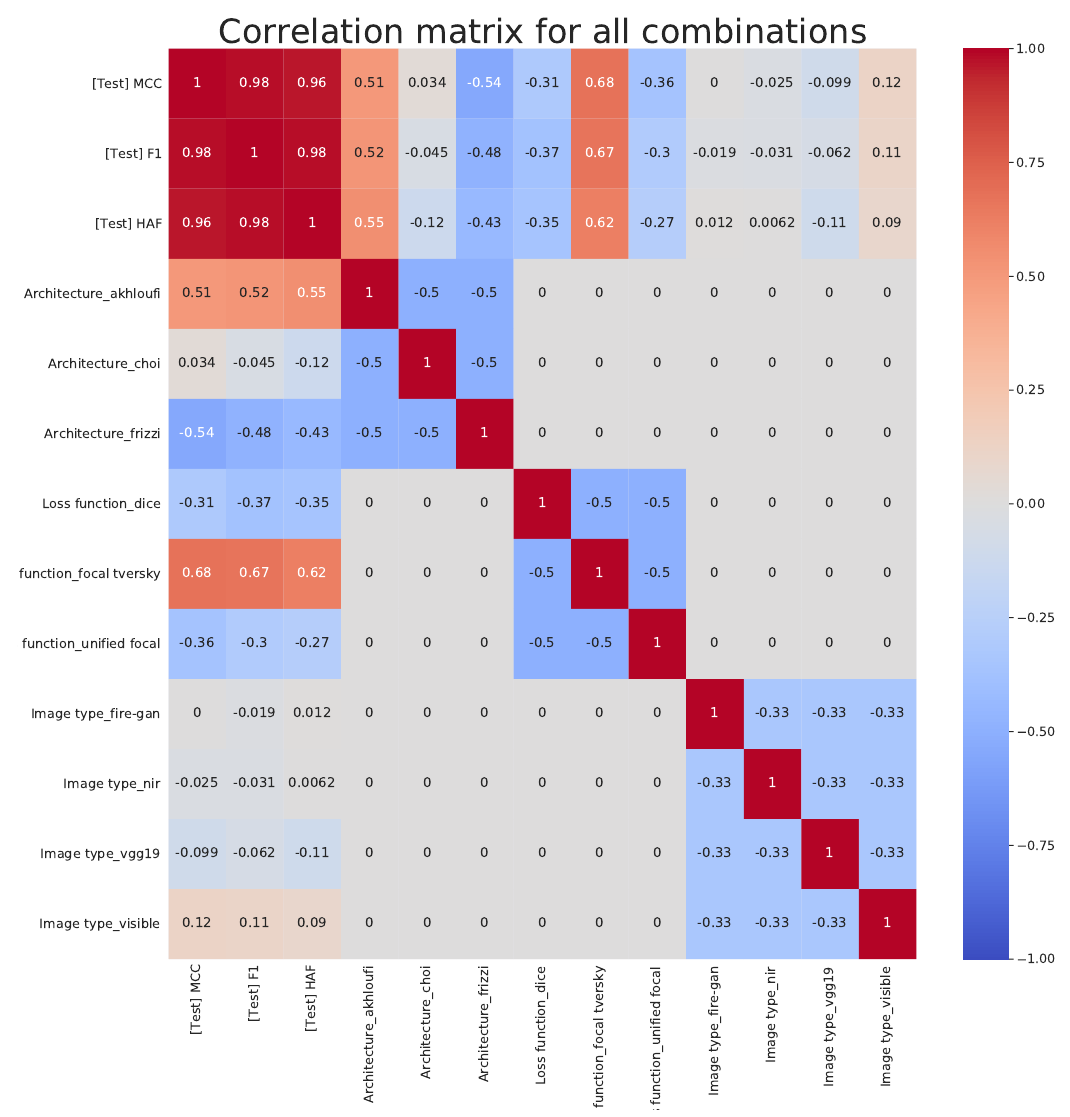
Figure 18. Spearman correlation matrix for all parameters. Considering the obtained results, both in terms of performance and robustness, we choose the Akhloufi + Focal Tversky + visible combination as the best one and use it for comparison against the best traditional method identified by Toulouse et al. [11]. Table 3 shows the results of this comparison. Table 3. Comparison between the best combination and the best traditional method per metric. The best performing method per metric is highlighted in bold. Metric Method